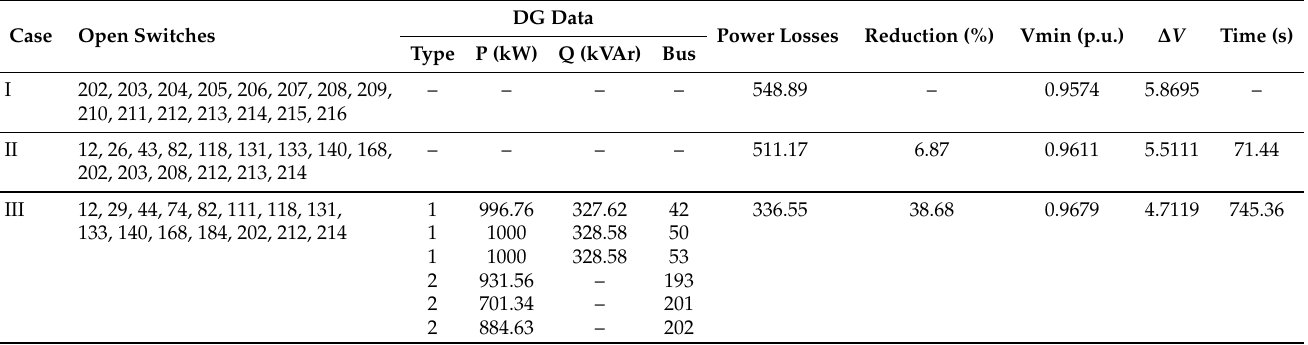
Table 8. Results for the 202-bus test system.